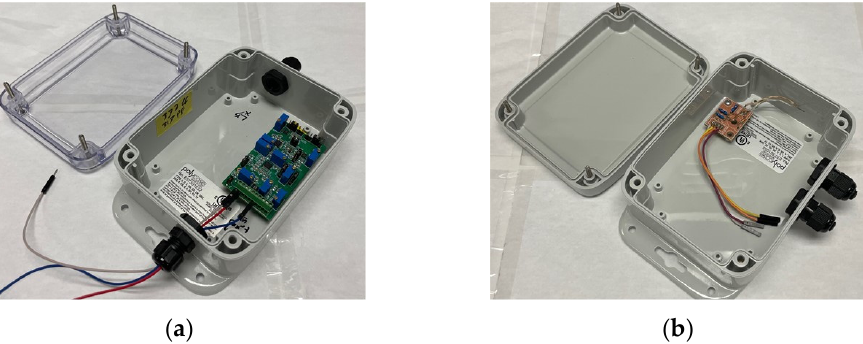
Figure 4 . ( a ) The capacitive sensor board and ( b ) the Wheatstone bridge packaged in a weatherproof enclosure.